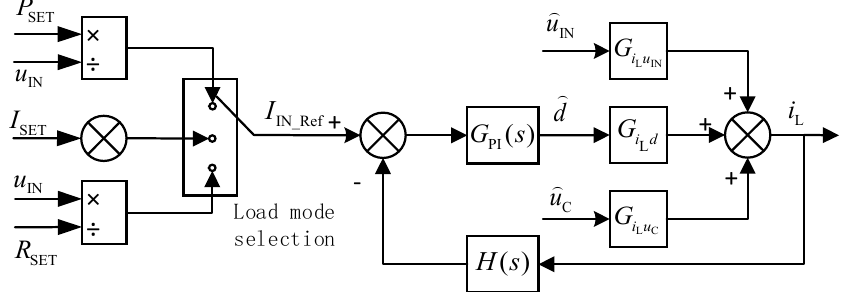
Figure 2. Block diagram of load simulation algorithm based on input current tracking.